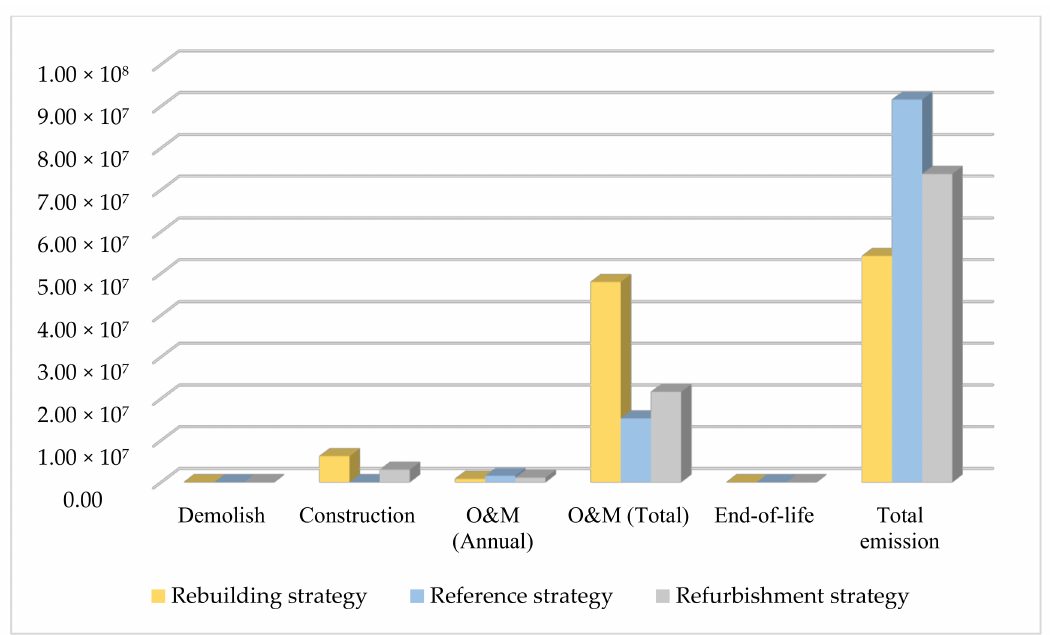
Figure 7. The CO 2 emissions in the life cycle phases of the different strategies.